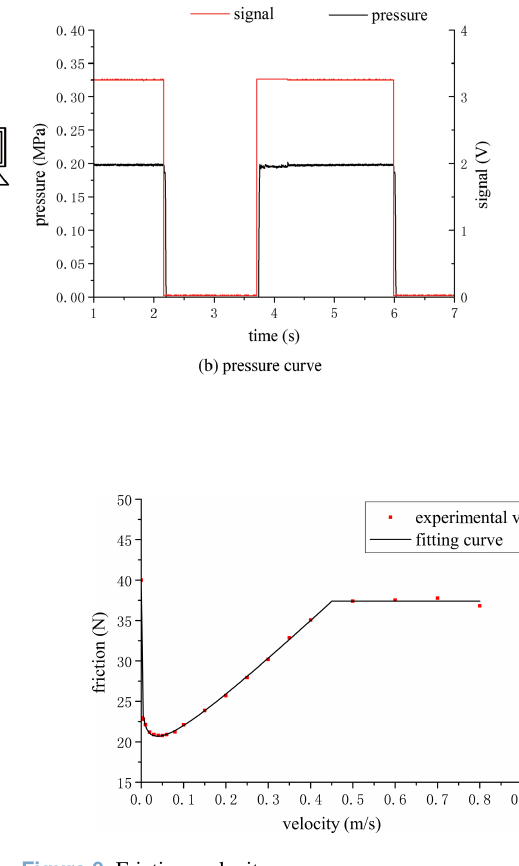
Figure 9. Friction–velocity